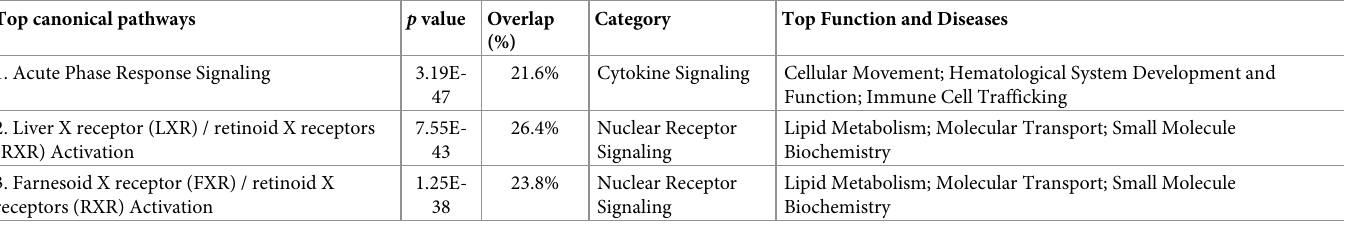
Table 1. Ingenuity pathway analysis (IPA) of the 228 perilymph proteins from patients with normal hearing. The three top ranking canonical pathways, p -values, per- cent overlap, category definition, and associated function and diseases are shown. Top canonical